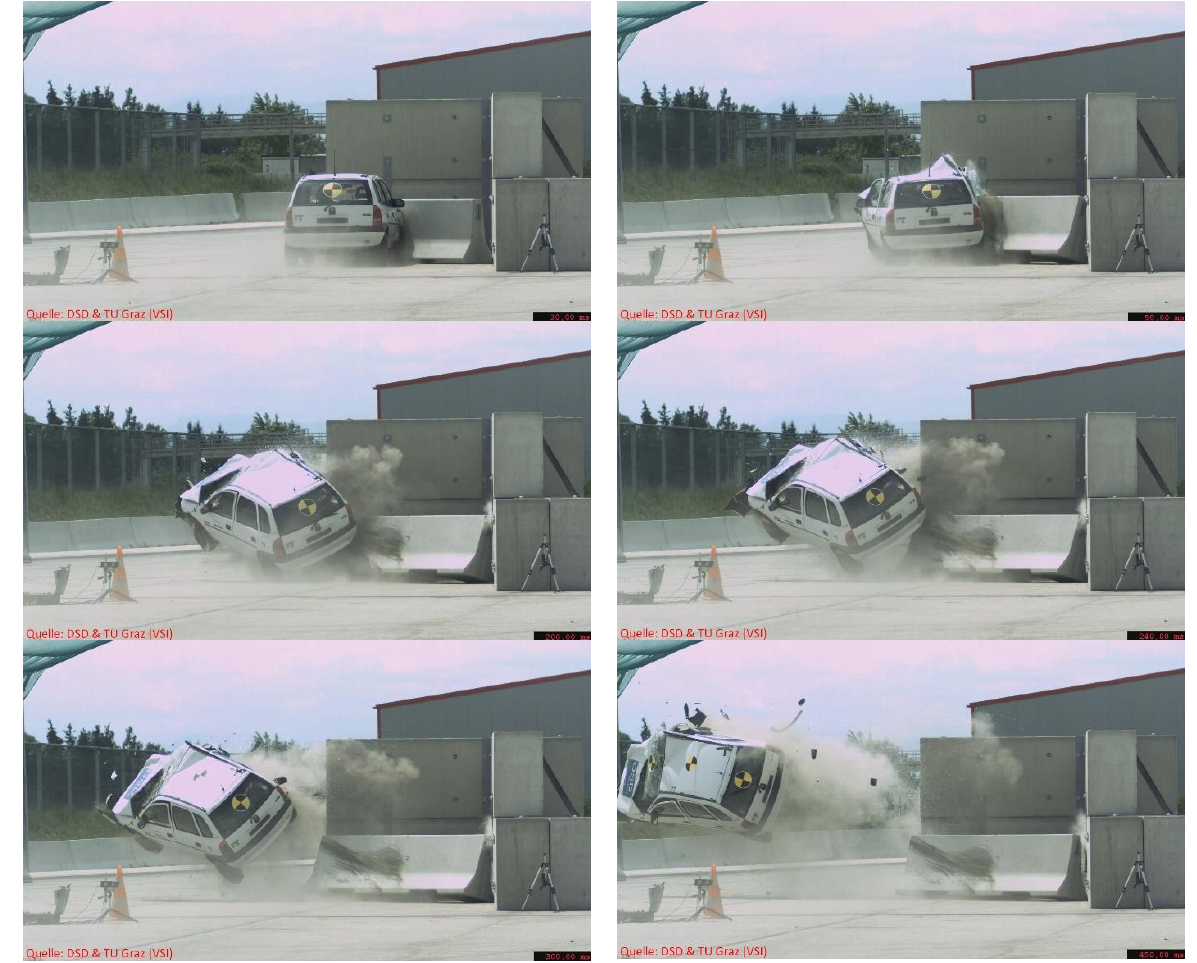
Figure 8. Vehicle motion impacting a 4 m concrete barrier. The vehicle impacts the barrier, lifts up and is rotating counter clockwise to its own longitudinal axis and redirected into the road lane.